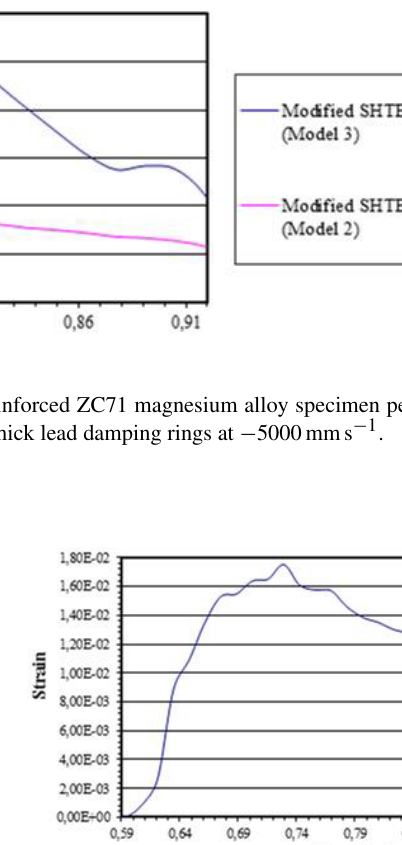
Figure 13. Strain-time curve in the centre of the SiC-reinforced ZC71 magnesium alloy specimen pertinent to the modified SHTB including the interruption device (Model 3) when using 1mm thick lead damping rings at − 5000mms − 1 .